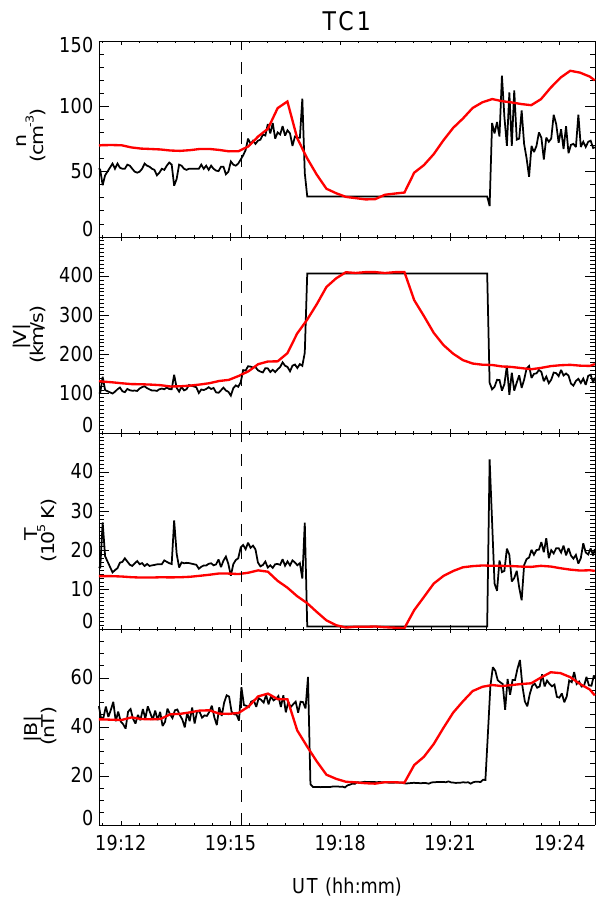
Fig. 7. Ions density, total velocity, temperature, and magnetic field magnitude observed by HIA and FGM instruments onboard TC1 (black lines) and predicted by the MHD code (red lines). Vertical dashed line marks the arrival of